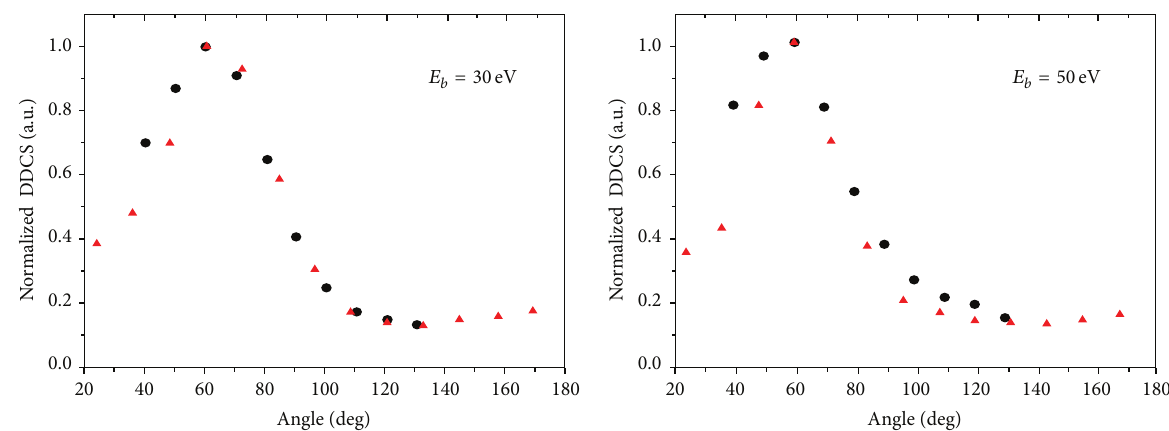
Figure 17: Present measurements of ( ∙ ) DDCS for H 2 at 250eV electron impact energy for 30 and 50 eV detection electron energies, respectively. The symbol ( ) shows the published results of DDCS from Shyn et al. [47].